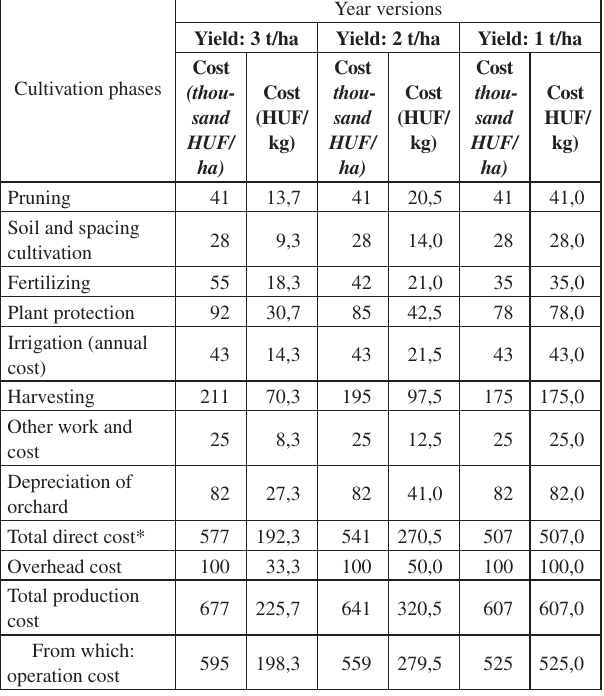
Table 2: The production cost of a walnut orchard in cultivation phases cul- tivated on a good standard in a whole year in case of different year versions